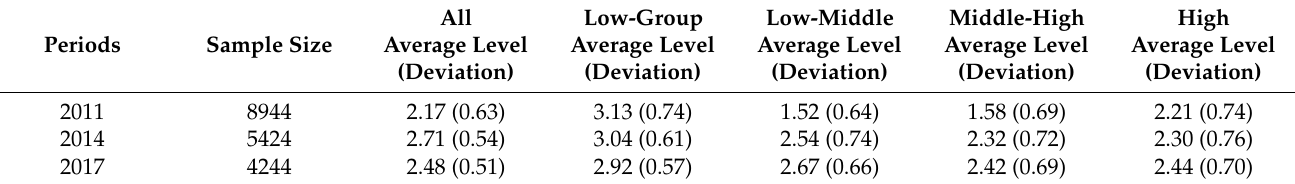
Table 3. Sample data